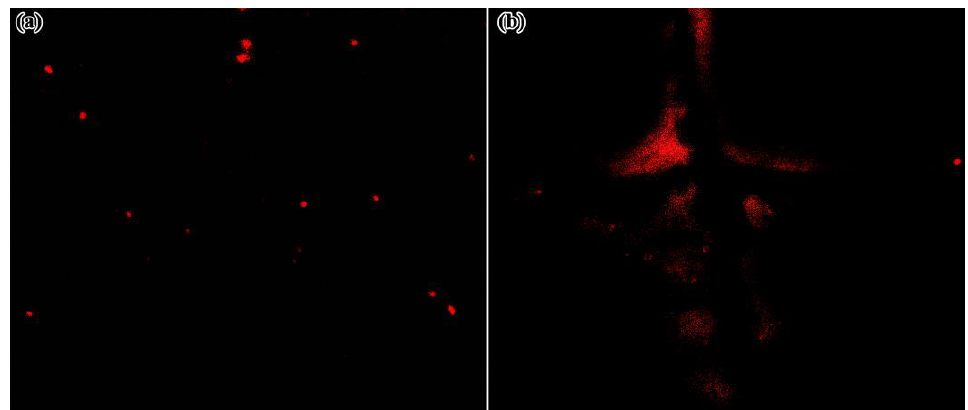
Figure 13. Corrosion detection performance of RBA/ZEO/epoxy coatings, ( a ) coating sample of accelerated corrosion by polarization and ( b ) defective coating with X-shaped scratch.